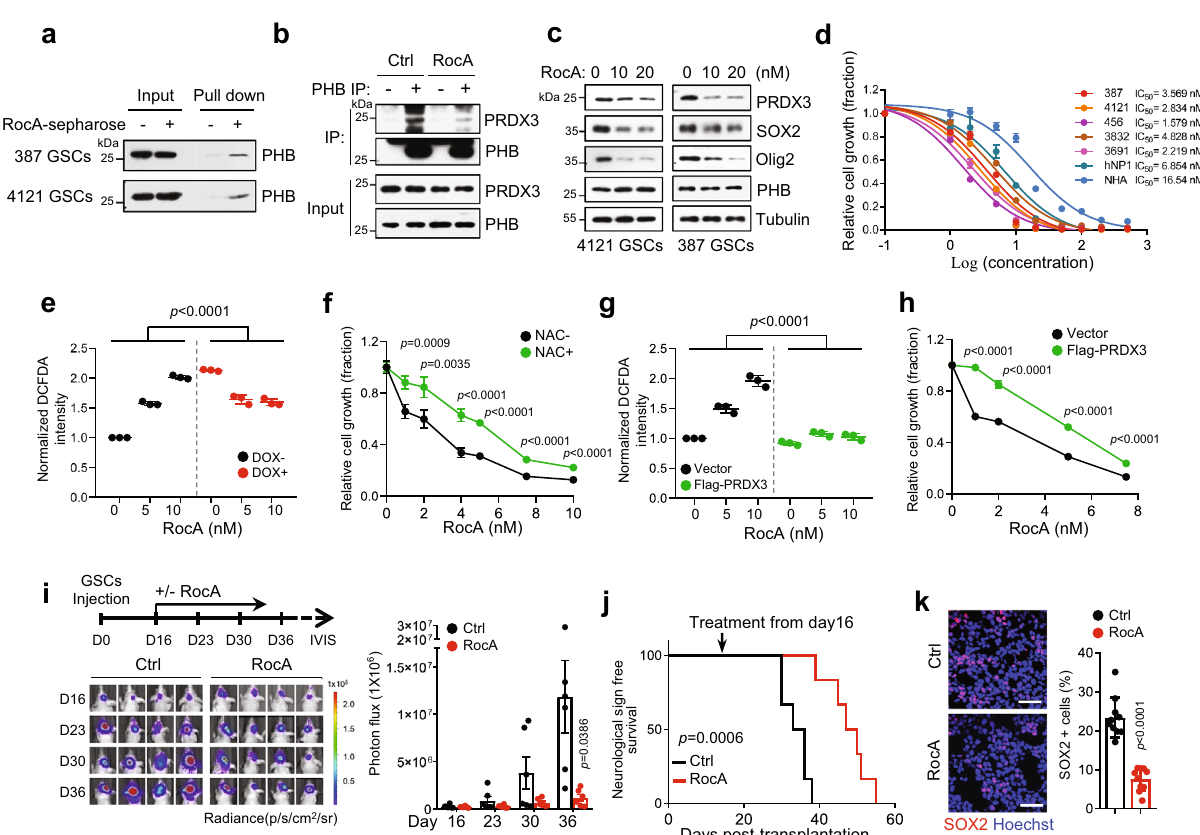
Fig. 6 Pharmacological targeting PHB inhibits GSC growth and tumorigenesis. a The association of RocA and PHB was analyzed by RocA-conjugated sepharose pull-down in GSCs. b Co-IP of PHB in 4121 GSCs treated with RocA (10 nM) and MG132 (10 μ M) for 12 h and IB for PHB and PRDX3 are shown. c IB showing the levels of indicated proteins in GSCs treated with increasing dose of RocA for 12 h. d Dose – response curves of RocA treatment in multiple GSC lines, hNP1 and NHA. Cells were treated with increasing dose of RocA for 48 h. IC 50 values of RocA were measured using nonlinear regression analysis of dose – response curves (mean ± SD, n = 3, biologically independent experiments). e , g The peroxide levels, as indicated by DCFDA fl uorescence, were measured by fl ow cytometry in Ctrl or PHB inducible-KD 4121 GSCs (DOX, 100 ng/ml) ( e ), or in Flag-vector or Flag-PRDX3 expressed 4121 GSCs ( g ) treated with increasing dose of RocA for 18 h (mean ± SD, n = 3, biologically independent experiments, two-way ANOVA). f , h 4121 GSCs cultured with or without 5 mM NAC ( f ), or expressed with Flag-vector or Flag-PRDX3 ( h ), were treated with indicated doses of RocA for 3 days. Cell growth was assessed by cell viability assay. Data were normalized to the untreated cells of each group (mean ± SD, n = 4 ( f ) or n = 3 ( h ), biologically independent experiments, unpaired two-sided Student ’ s t- test, no adjustment). i – k Nude mice (nu/nu) intracranially implanted with 4121 GSCs (Luciferase) were randomly grouped ( n = 6) at day 16 and treated with or without RocA (2.5 mg/kg, every 3 days, 8 times in total), as shown by schematic representation ( i , top). GBM xenografts were tracked by bioluminescence and the representative images are shown ( i , left). Bioluminescent quanti fi cation of tumor growth is shown ( i , right; mean ± SEM, Welch ’ s two-sided t- test). Kaplan – Meier survival plot of mice is shown ( j , Log-rank Mantel – Cox test). IF staining of SOX2 in GBM xenografts with indicated treatments and the representative images are shown ( k , left). Quanti fi cations of SOX2 + cells are shown ( k , right) (mean ± SD, images n = 10, from fi ve biologically independent samples, Unpaired two-sided Student ’ s t -test, no adjustment). Nuclei were counterstained with Hoechst (blue). Scale bars, 40 μ m. Source data are provided as Source Data fi